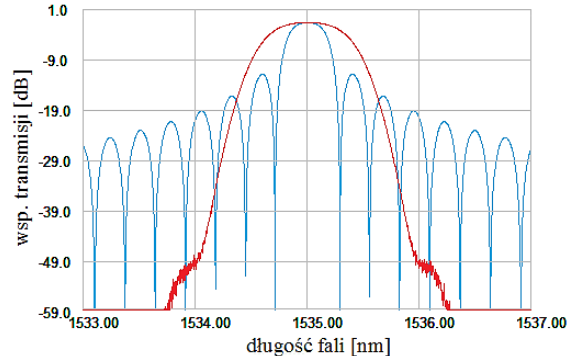
Fig. 20. Comparison of Bragg fiber gratings spectral characteristics without apodization – blue line and apodized Blackman function for wsp. X=3 and Y=1 –red